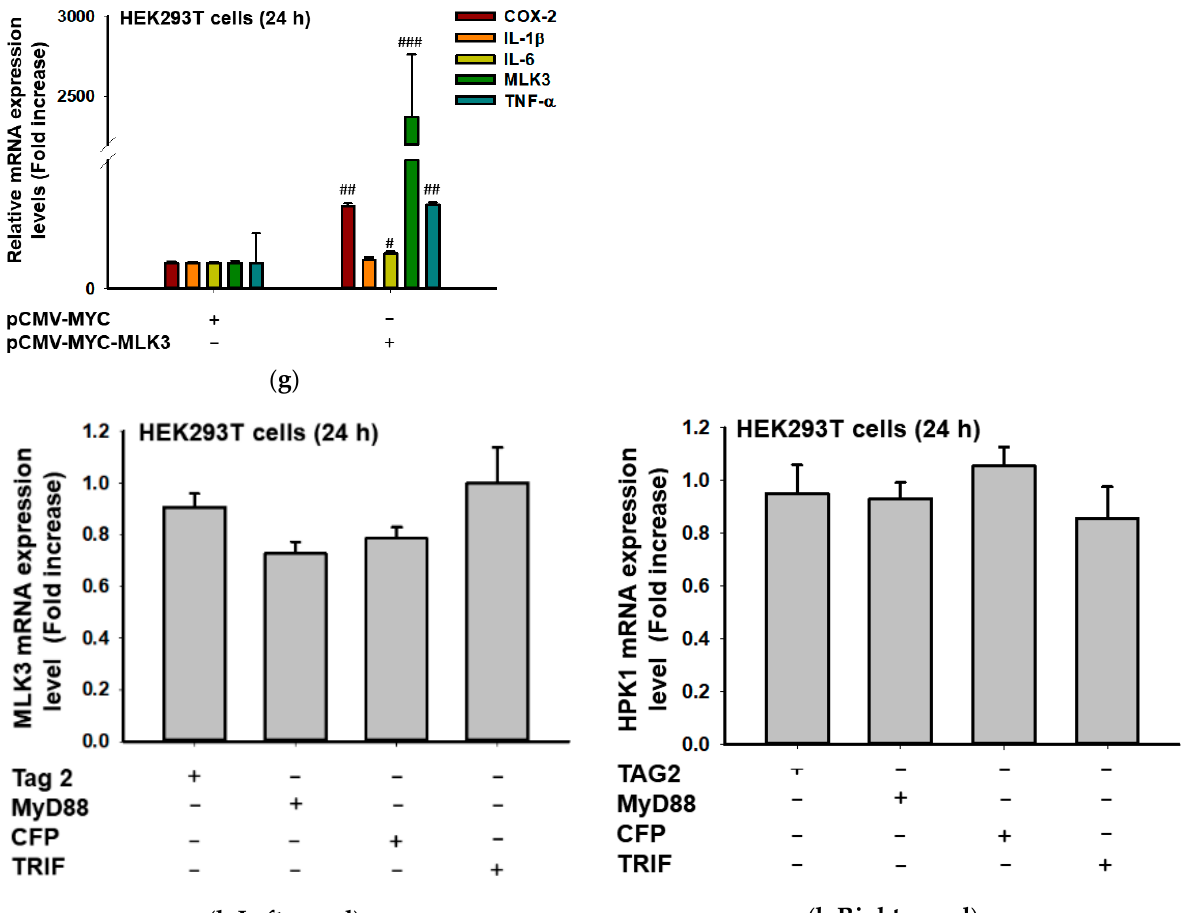
Figure 1. Effect of MLK3 on AP-1 activation. ( a , g , h ) The mRNA expression levels of MLK3 and HPK1, as well as inflammatory genes (COX-2, IL-1 β , IL-6, and TNF- α ) were determined by real- time PCR from HEK293 cells transfected with Myc-MLK3 ( a , g ) or adapter molecules (MyD88 and TRIF) ( h ). ( b – f ) Luciferase activity mediated by AP-1, NF- κ B, IRF3, and GATA/T-bet/NF-AT in HEK293 cells transfected with Myc-MLK3 and AP-1-Luc, NF- κ B-Luc, STAT3-Luc, IRF-3-Luc, or IFN- γ -promoter-Luc was determined by luminometer. Results ( a – f ) are expressed as mean ± SD. # p < 0.05, ## p < 0.01, and ### p < 0.001 compared to the normal group (no treatment). MYC: empty vector (PCMV) with MYC.